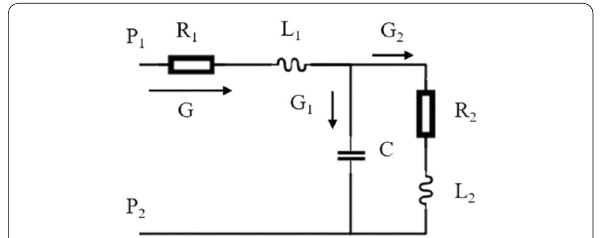
Figure 8 Analogical LC electrical circuit